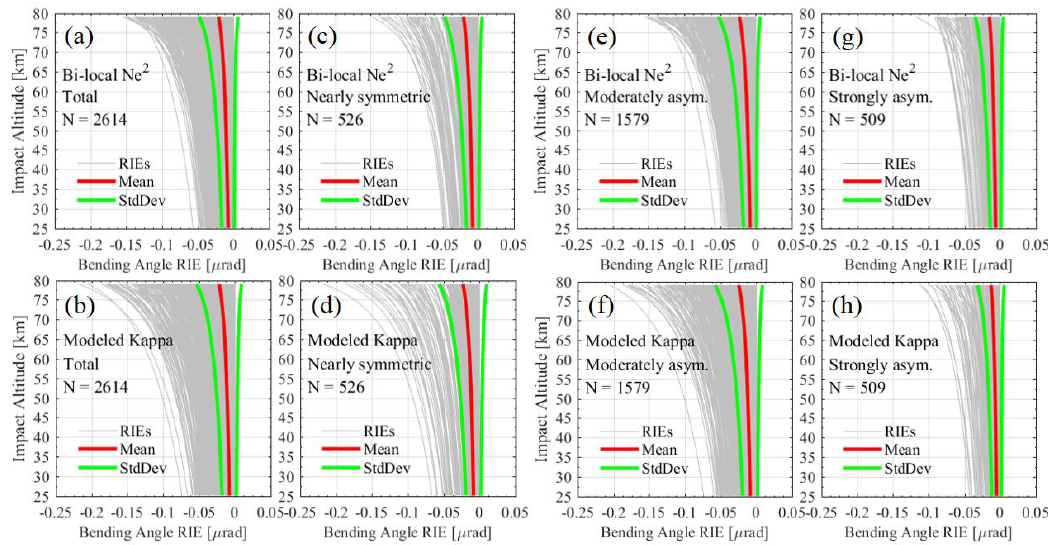
Figure 7. Bi-local Ne 2 term (top) and modeled Kappa (bottom) bending angle RIE correction profiles and their statistics, shown for the global ensemble total data set in ( a , b ) from the MetOp-A/-B RO events on all three test days as well as for the classified nearly symmetric, moderately asymmetric, and strongly asymmetric partial data sets in ( c , d ), ( e , f ), and ( g , h ), respectively.